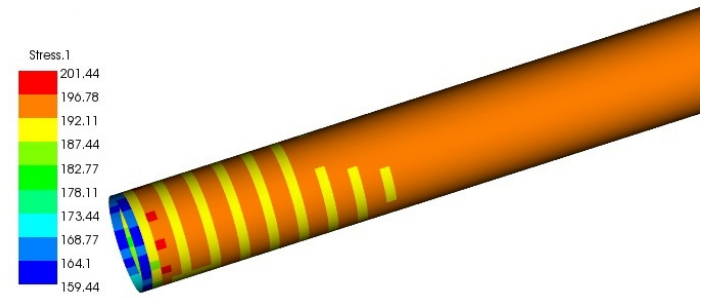
Figure 7. The stress of 0° fiber.